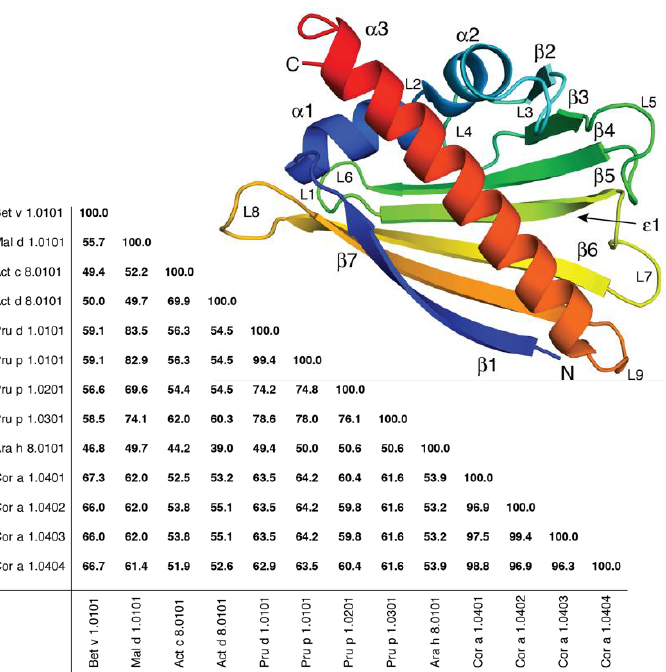
Figure 1. Sequence-identity matrix of thirteen selected PR-10 allergens from birch pollen ( Betula verrucosa , Bet v 1), apple ( Malus domestica , Mal d 1), golden kiwi fruit ( Actinidia chinensis , Act c 8), green kiwi fruit ( Actinidia deliciosa , Act d 8), plum ( Prunus domestica , Pru d 1), peach ( Prunus persica , Pru p 1), peanut ( Arachis hypogaea , Ara h 8), and hazelnut ( Corylus avellana , Cor a 1). The structure of Bet v 1 (PDB: 4A88, isoform Bet v 1.0101) is displayed above. Secondary-structure elements and the nine connecting loops (L1 – L9) are labeled, and N- and C-termini are indicated. The main entrance ( ε 1) to the inner cavity of the protein is indicated by an arrow.